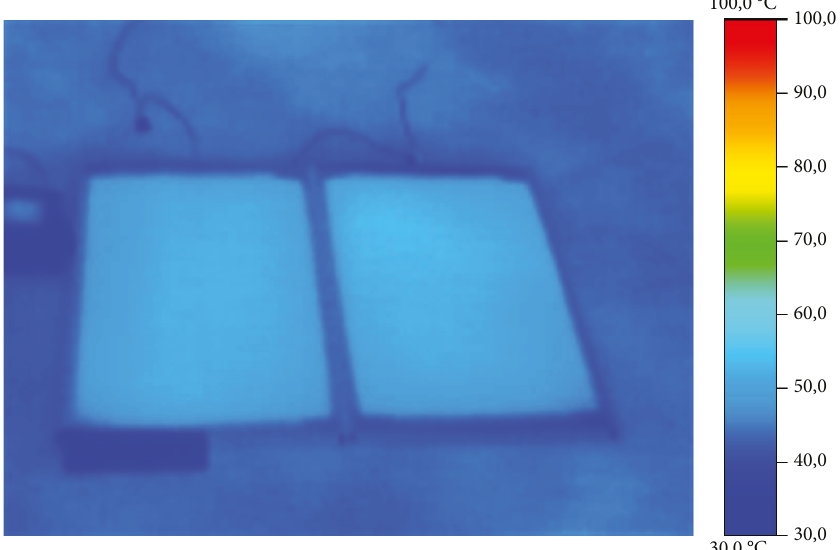
V = 34V ). 26 September 2017, Aversa (CE), Italy. 4 ( PV = 25 ° C amb